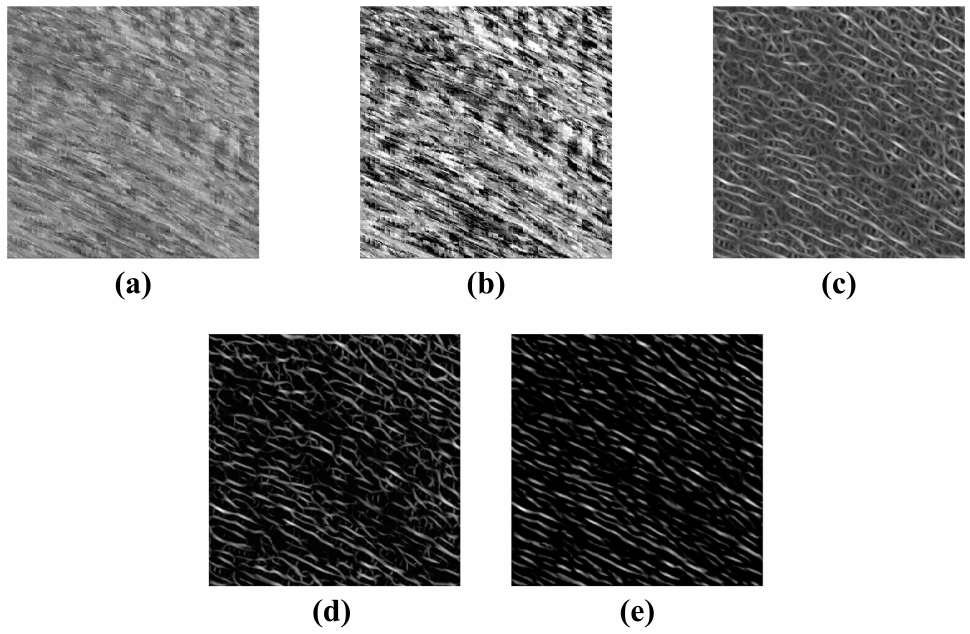
Figure 3. The results of preprocessing of space-time image. ( a ) The original. ( b ) The MSR enhance- ment of ( a ). ( c ) The result of the Fourth-order Gaussian derivative steerable filter enhancement of ( b ). ( d ) The result of noise filtering function enhancement of ( c ). ( e ) The result of orientation-filtering function enhancement of ( d ).